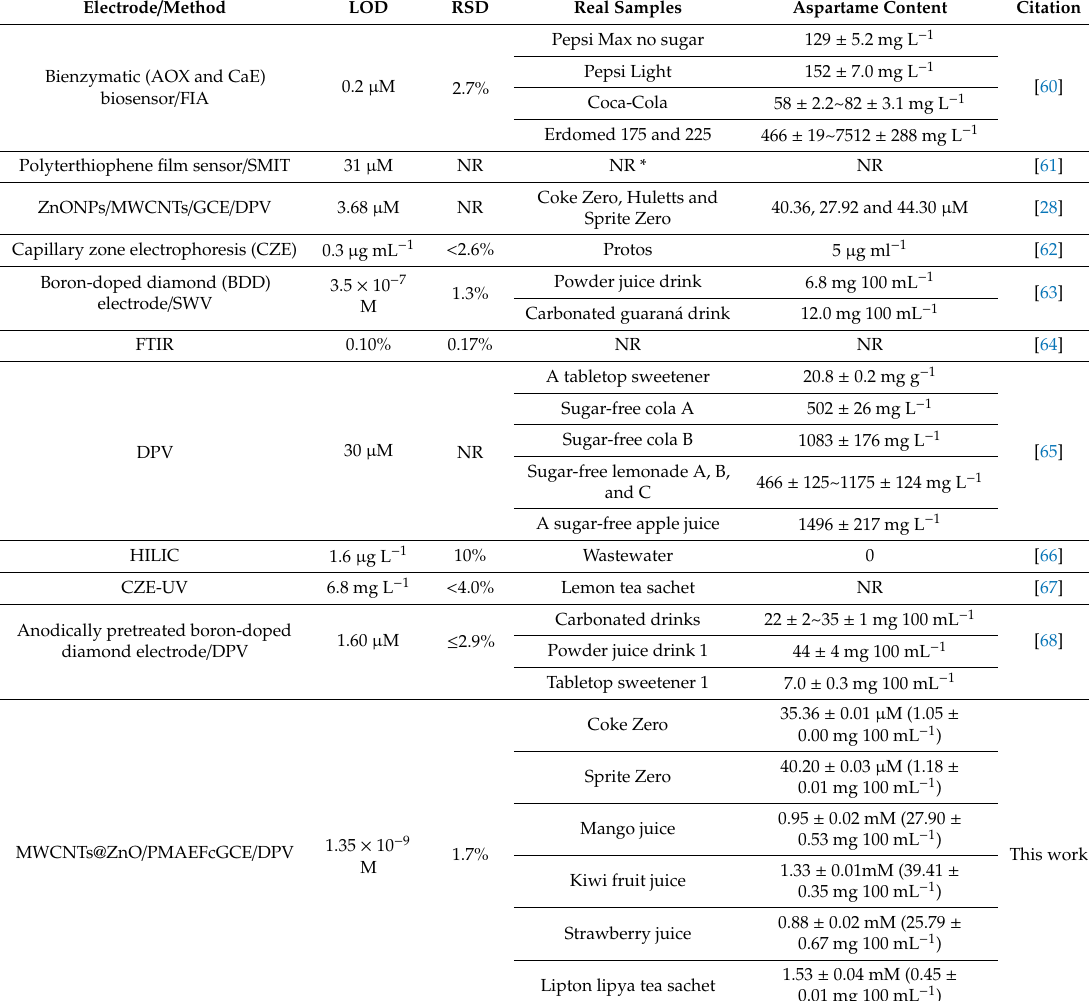
Table 1. Comparison of characteristic parameters of di ff erent techniques with those of our system Electrode / Method LOD RSD Real Samples Aspartame Content